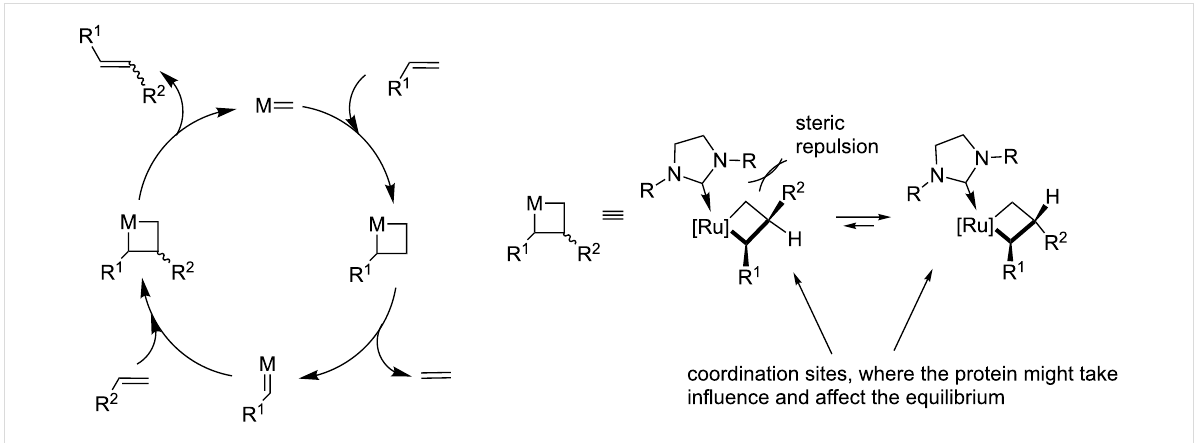
Scheme 1: Left: Mechanism of the olefin metathesis reaction postulated by Chauvin [2]. Right: Potential influence of the protein as second coordina- tion sphere in the transition state that lead to different metathesis